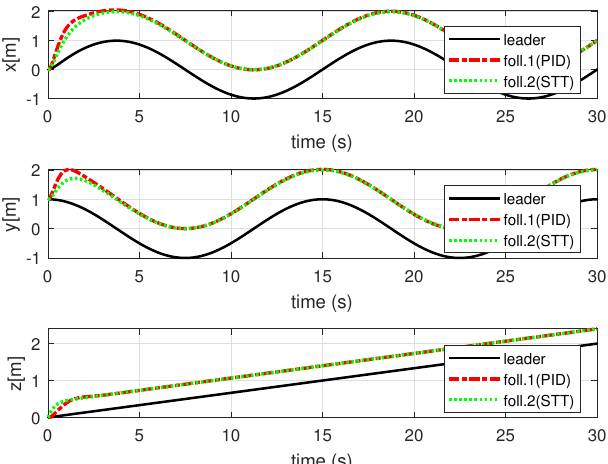
Figure 10. The results of the comparison simulation for the formation control of quadrotors about the 4 π circular trajectory: The red dashed line is the result of the formation control using the PID control method, and the green dashed line is the result of the formation control using the proposed formation control method with the state transformation technique (STT).